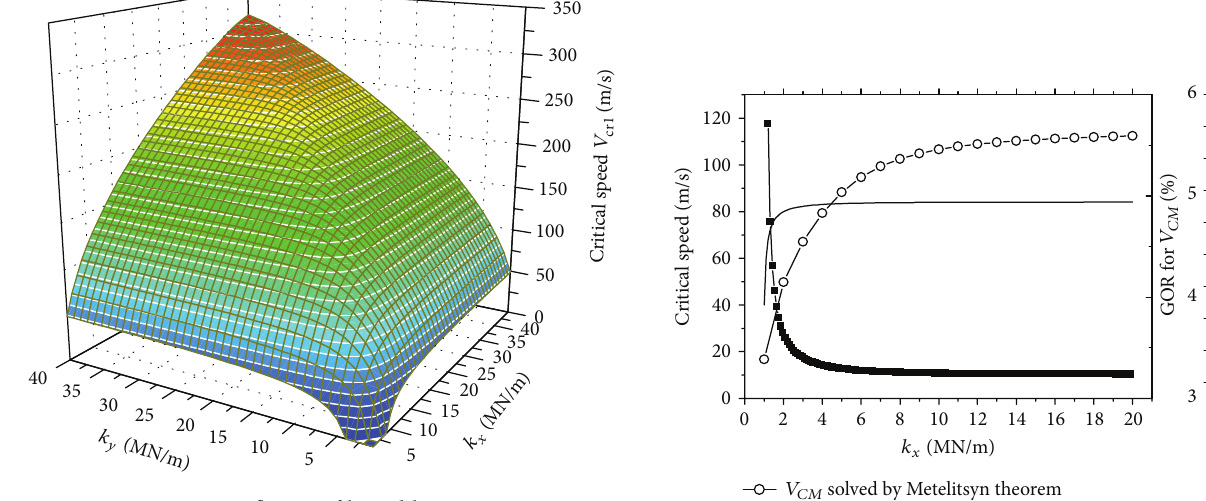
Figure 4: Influence of 𝑘 𝑥 and 𝑘 𝑦 on 𝑉 𝐶𝑀 .